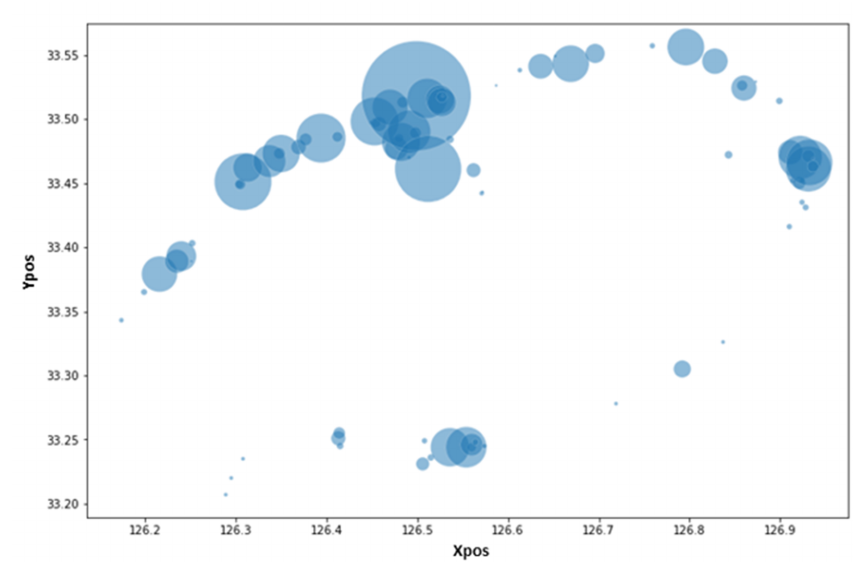
Figure 2. Distribution of rental locations between Jeju City and Seogwipo City.